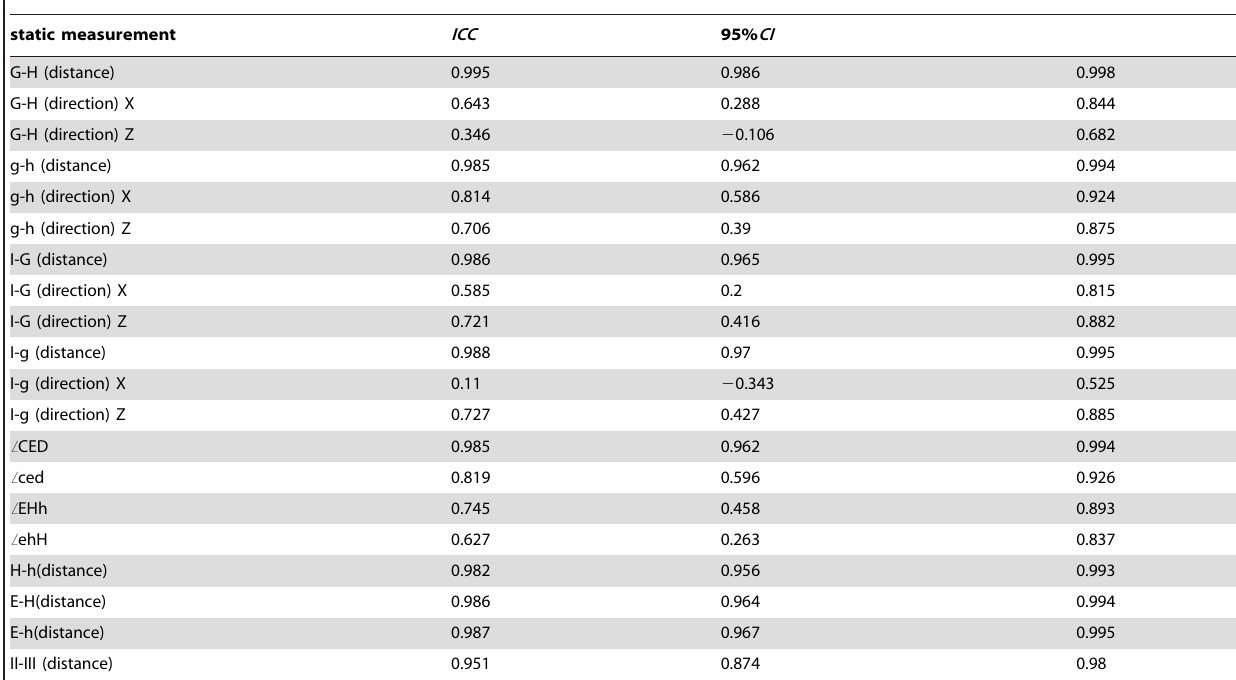
Table 2. Static measurement ICC